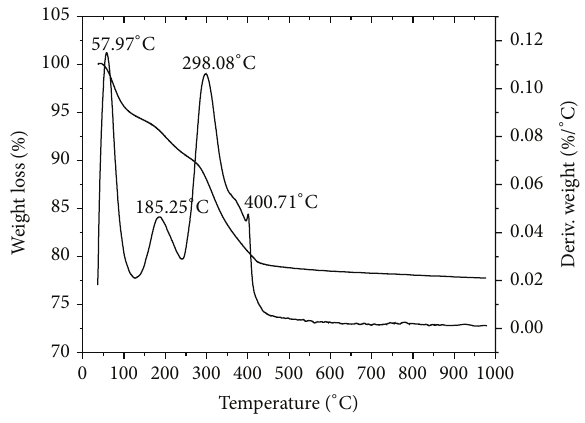
Figure 1: TGA and DTG profiles of Zr(OH) 4